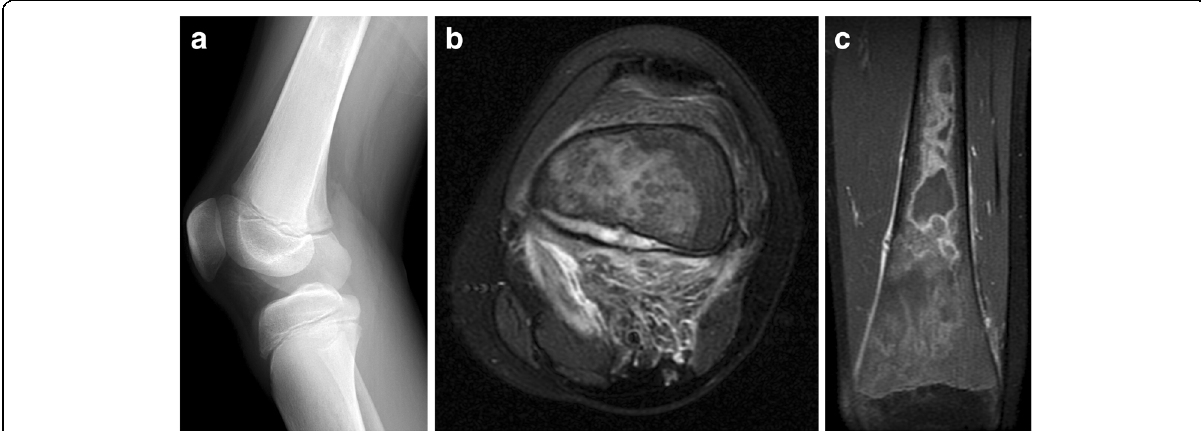
Fig. 10 Bone infarct and subperiosteal hemorrhage mimicking osteomyelitis in Gaucher disease. A 13-year-old male presented with atraumatic knee pain and swelling. Initial lateral knee radiograph ( a ) showed subtle periosteal reaction along the posterior metadiaphysis of the distal femur and ill- defined intramedullary sclerosis within the femoral shaft. Follow-up MRI demonstrated intramedullary marrow edema and focal subperiosteal fluid with surrounding inflammatory changes in the popliteal fossa thought to be related to subperiosteal hemorrhage on axial T2-weighted image ( b ). Coronal post-contrast T1 fat-saturated image ( c ) demonstrated peripheral serpentine enhancement of areas of bone infarction within the distal femur. The patient was subsequently diagnosed with Gaucher disease after initial workup for hematopoietic